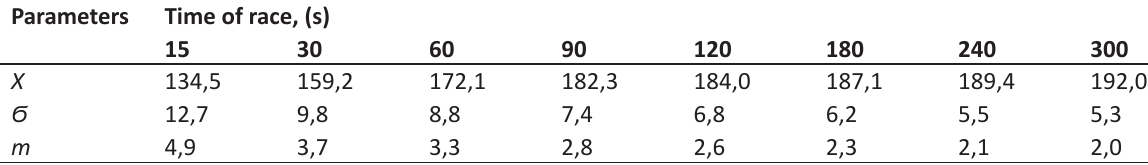
Table 4. Change in the speed of the distance 4 km, depending on the pulse